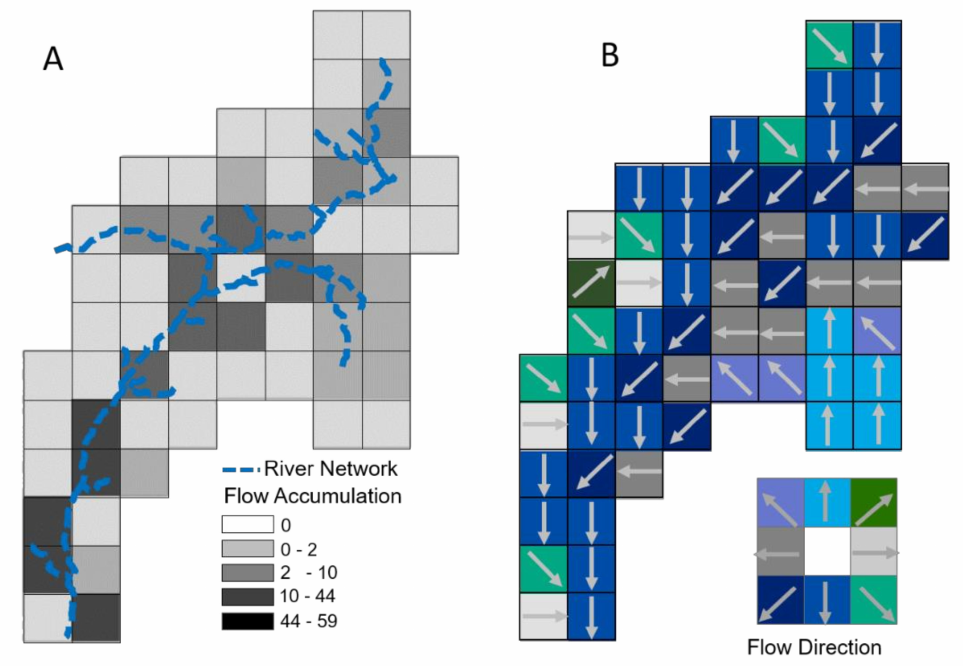
Figure 6. Raster input data for Hapi: ( A ) Flow Accumulation; ( B ) Flow